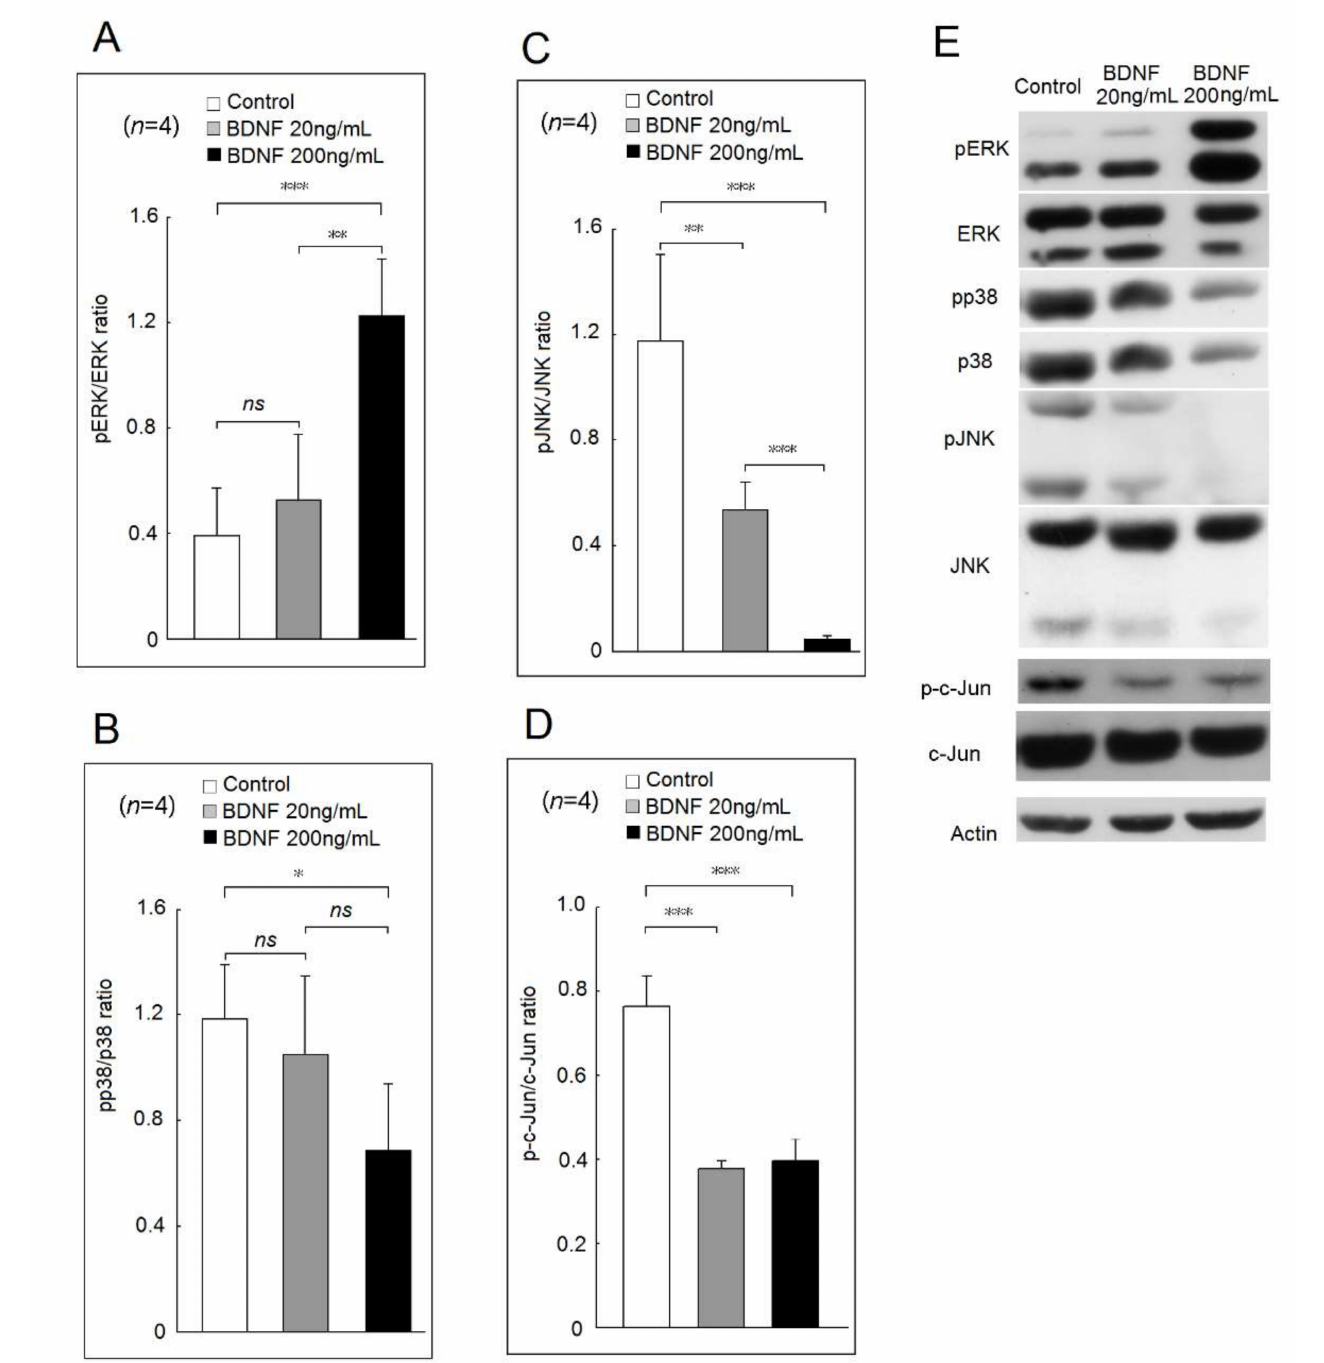
Figure 3. Effects of BDNF at concentrations of 20 ng/mL and 200 ng/mL in mitogen-activated protein kinase (MAPK) and c-Jun phosphorylation of U937 cells. The phosphorylation ratio of ( A ) extracellular signal-regulated kinases (ERK), ( B ) p38, ( C ) c-Jun N-terminal kinases (JNK) and ( D ) c-Jun in U937 cells after cultured with medium only, low concentration of BDNF (20 ng/mL) or high concentration of BDNF (200 ng/mL) for 48 h. ( E ) A representative case (ns, not significant; * p < 0.05; ** p < 0.01; *** p <